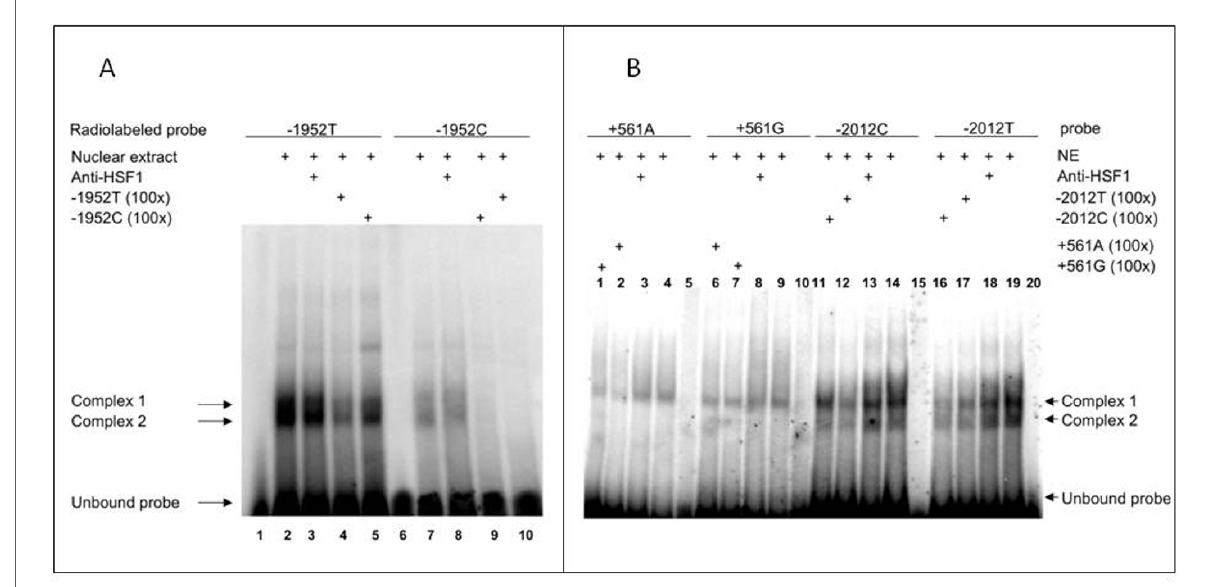
Figure 2 A, electrophoretic mobility shift assay (EMSA) with radiolabeled either -1952T or -1952C probe and HEK-293 cell nuclear extracts (NE) and B, EMSA assays with radiolabeled either -2012T/-2012C and +561G/+561A probes and HEK-293 cell NE . A . Lanes 1 and 6, mobility of the labelled probes without NE; lanes 2 and 7, mobility of the labelled probes with NE in the absence of competitor. A specific nuclear protein bind- ing can be almost completely abolished both by 100-fold unlabeled -1952T but not with -1952C probe (lanes 4 and 5; lanes 9 and 10). Super shift assays incubating with anti-HSF1 antibody did not show any super shifted protein complex (lanes 3 and 8). B . Lanes 5, 10, 15 and 20, mobility of the labelled probes without NE; lanes 4, 9, 14, and 19, mobility of the labelled probes with NE in the absence of competitor. Competition assays with 100- fold unlabeled probes (lanes 1 and 2; lanes 6 and 7; lanes 11 and 12; lanes 16 and 17). Super shift assays incubating with anti-HSF1 antibody did not show any super shifted protein complex (lanes 3, 8, 13 and 18).